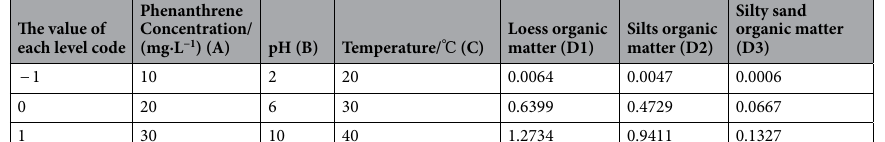
The value of each level